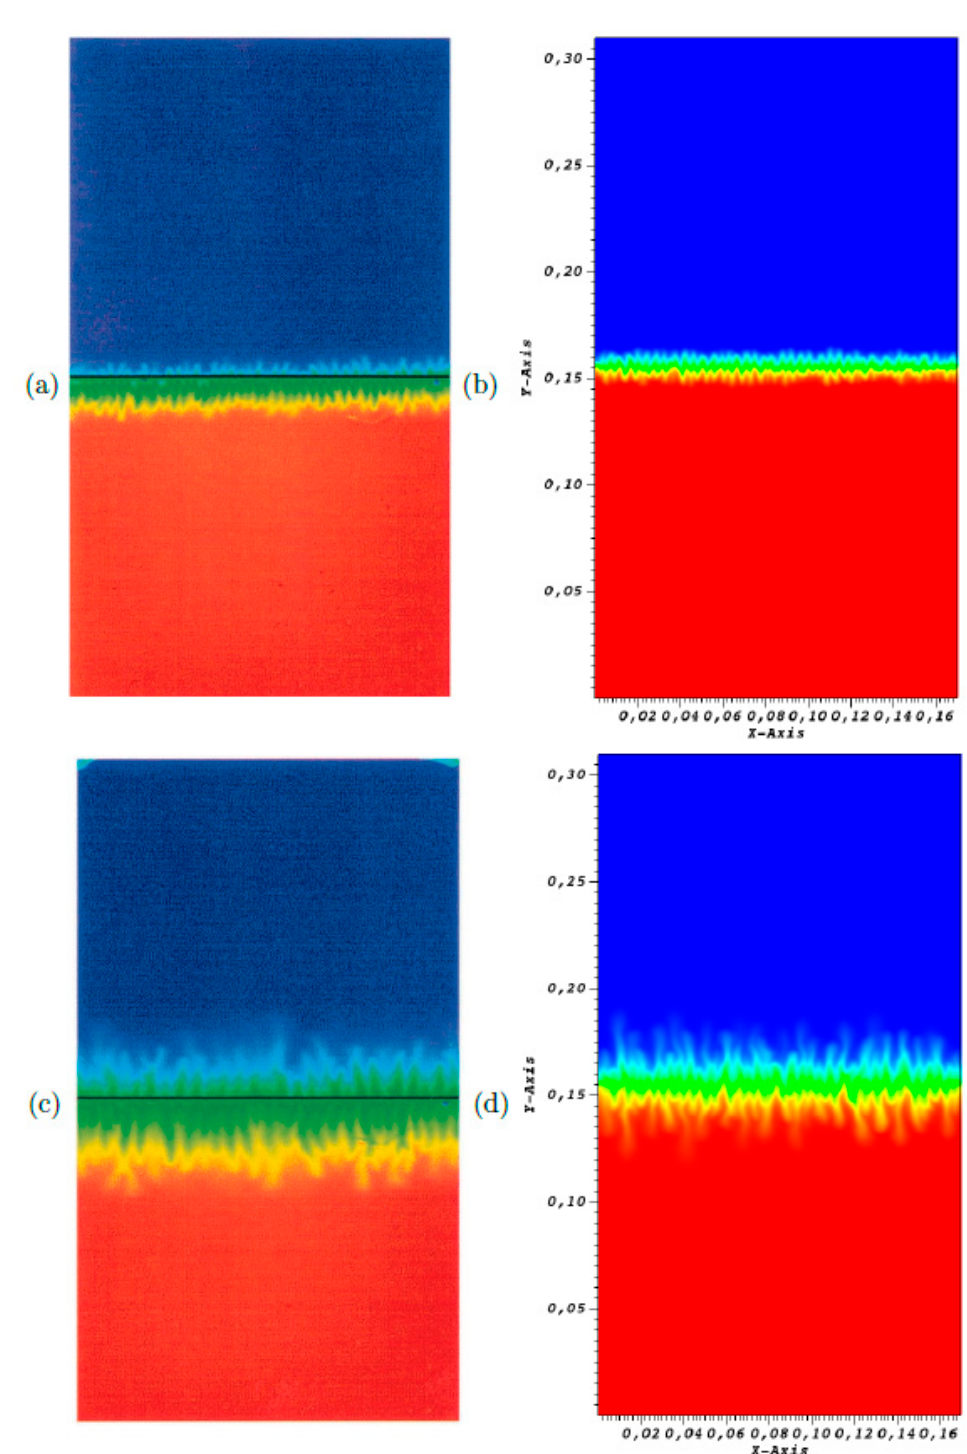
Figure 3. Normalized sucrose concentration for R ρ = 2.8. The normalized concentration ranges from zero (red) to one (dark blue). ( a ) Experimental data [42] at t = 522 min; ( b ) Numerical results at t = 522 min; ( c ) Experimental data [42] at t = 2993 min; ( d ) Numerical results at t = 2993 min. Additional calculations were performed using the stabilization parameter of Christie et al. [32] instead of that of Tezduyar and Osawa [33]. In this case, the solutions obtained